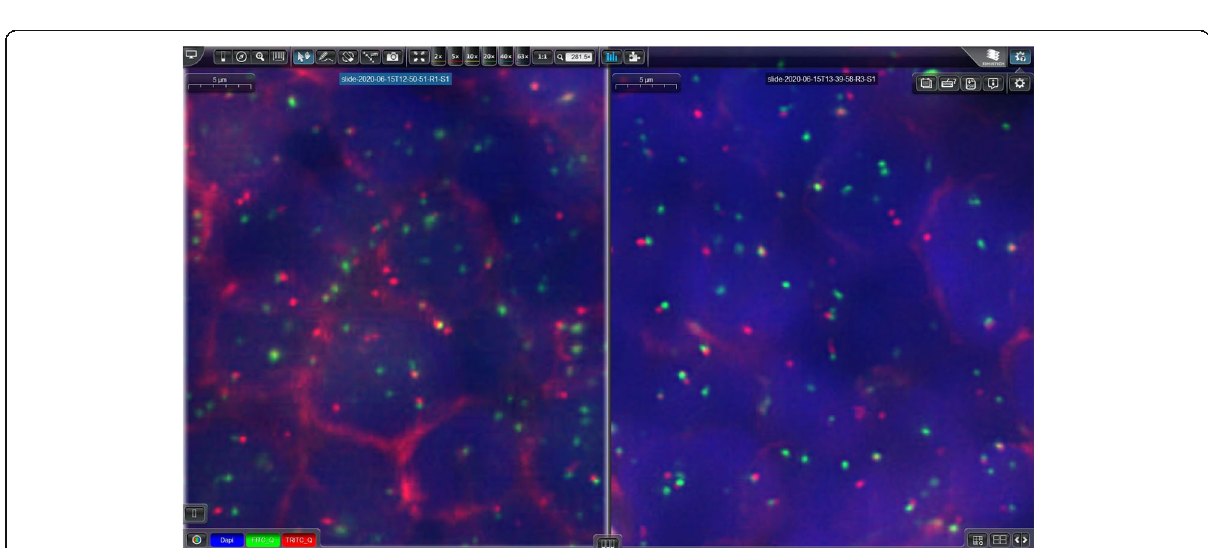
Fig. 1 Comparison of a case scanned by the low profile ( a ) versus high profile ( b ) using a C-MYC bap probe. The high profile results in a better signal to noise ratio without fading. The settings applied are shown in ( c ) resulting in different storage